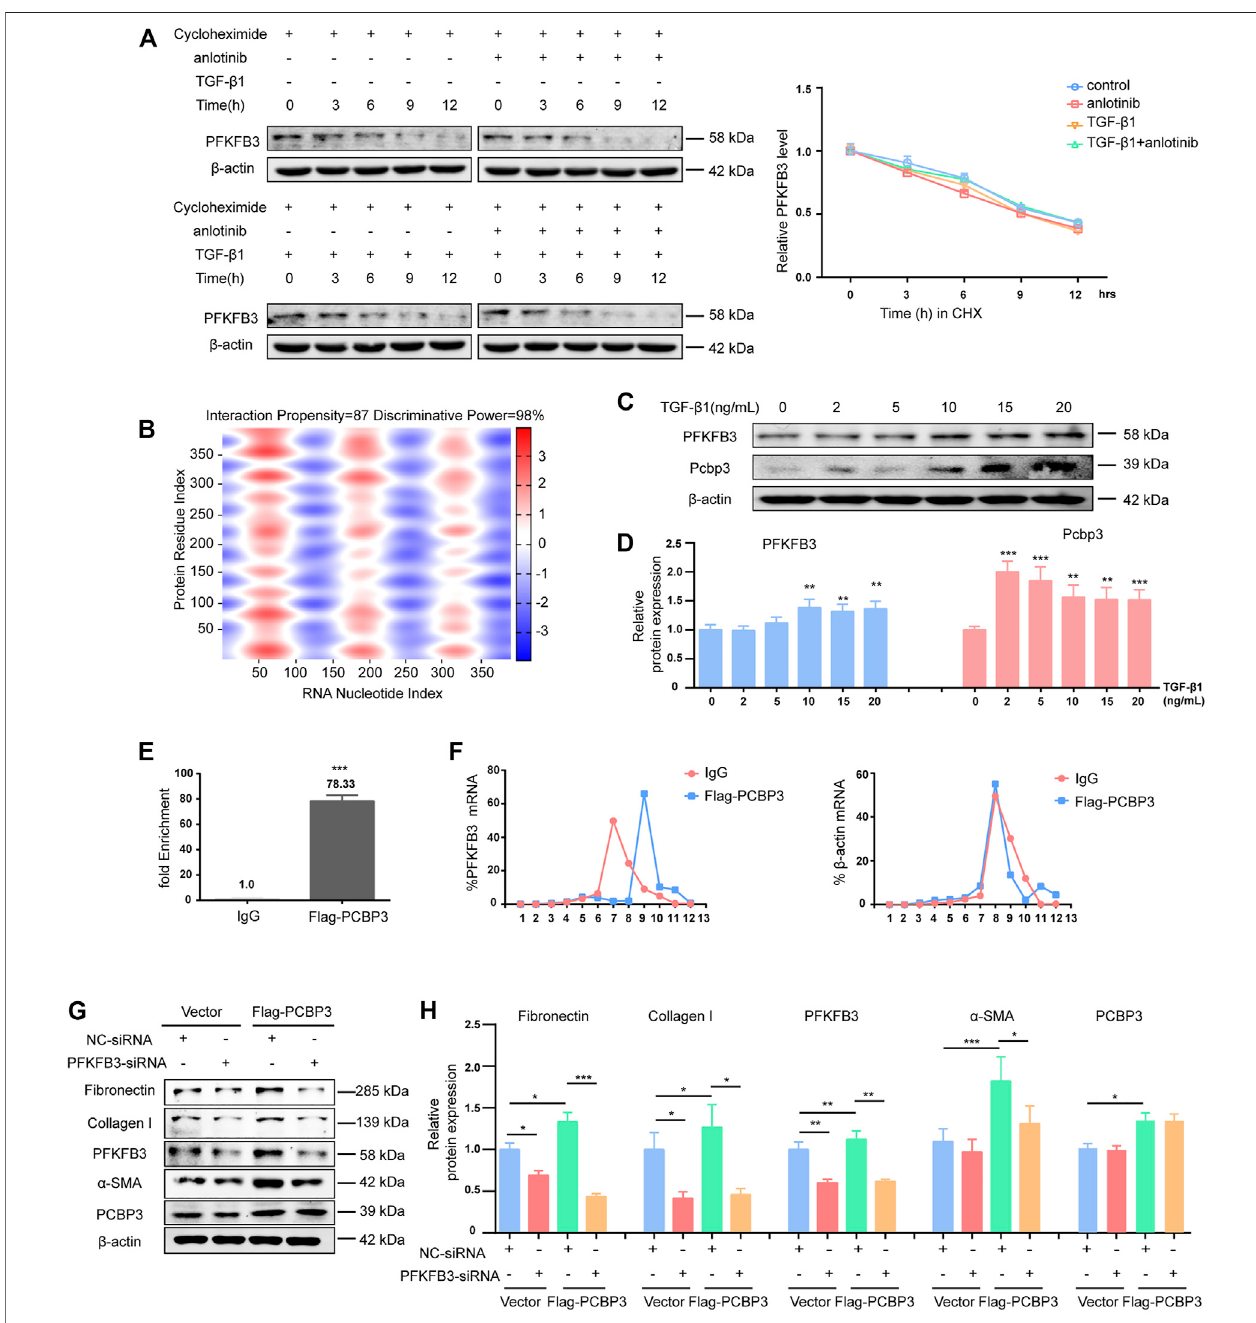
FIGURE 3 | PCBP3 posttranscriptionally increases PFKFB3 expression by promoting its translation during myo fi broblast activation. (A) PFKFB3 degradation in mouse lung fi broblasts when protein synthesis was inhibited by 50 μ M cycloheximide (mean ± SD, n (cid:1) 3). (B) Prediction of RNA – protein interaction of PFKFB3 mRNA with PCBP3 protein using the catRAPID algorithm. Red represents interaction strength. (C) Western blot analysis of PFKFB3 and PCBP3 protein levels in mouse lung fi broblastsstimulatedwithTGF- β 1fortheindicatedconcentrations. (D) Quanti fi cationofPFKFB3andPCBP3proteinlevelsrelativeto β -actinisshown(mean ± SD, n (cid:1) 3, ** p < 0.01, *** p < 0.001 compared with 0 by one-way ANOVA). (E) Quantitative RT-PCR (qPCR) to show the effect of PCBP3 overexpressing on PFKFB3 RNA immunoprecipitation (RIP) in mouse lung fi broblasts. Values were plotted as mean ± SD from three independent experiments. p value was calculated by Student t test. *** p < 0.001. (F) Mouselung fi broblastsexpressingFlag-PCBP3werefractionatedintocytoplasmicextractsthroughsucrosegradients.Thearrowindicatesthedirection ofsedimentation.ThedistributionofPFKFB3and β -actinmRNAswasquanti fi edbyRT-PCRanalysisofRNAisolatedfrom12gradientfractions.Statisticalanalyseswere performed using Student t test. *** p < 0.001. (G) Mouse lung fibroblasts were transfected with Flag-PCBP3, and then transfected with PFKFB3-siRNAs or NC-siRNA. The levels of Fibronectin 、 Collagen I 、 PFKFB3 、 α -SMA 、 PCBP3 and β -actin assessed by western blot. (H) Graphical representation of the relative levels of indicated proteins (mean ± SD, n (cid:1) 3, * p < 0.05, ** p < 0.01, *** p < 0.001 by ANOVA).